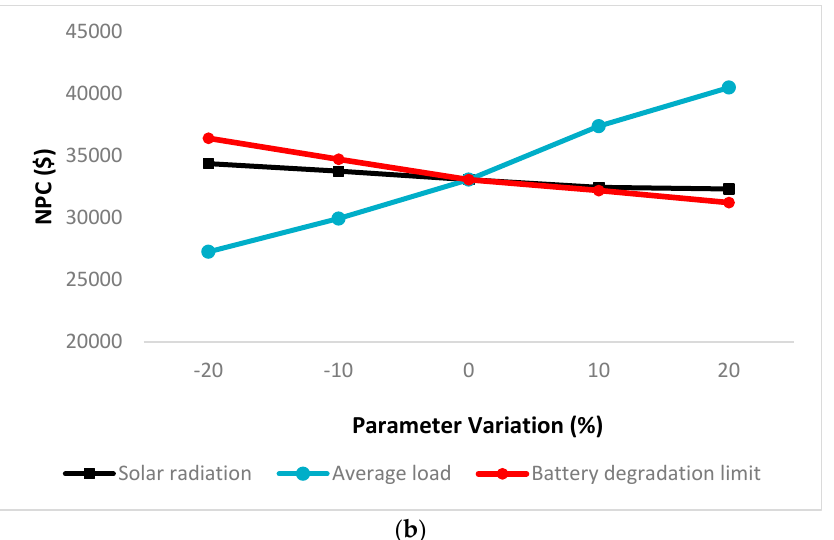
Figure 13. Effects of critical parameter variations on the NPC using ( a ) LF strategy and ( b ) CC strategy.